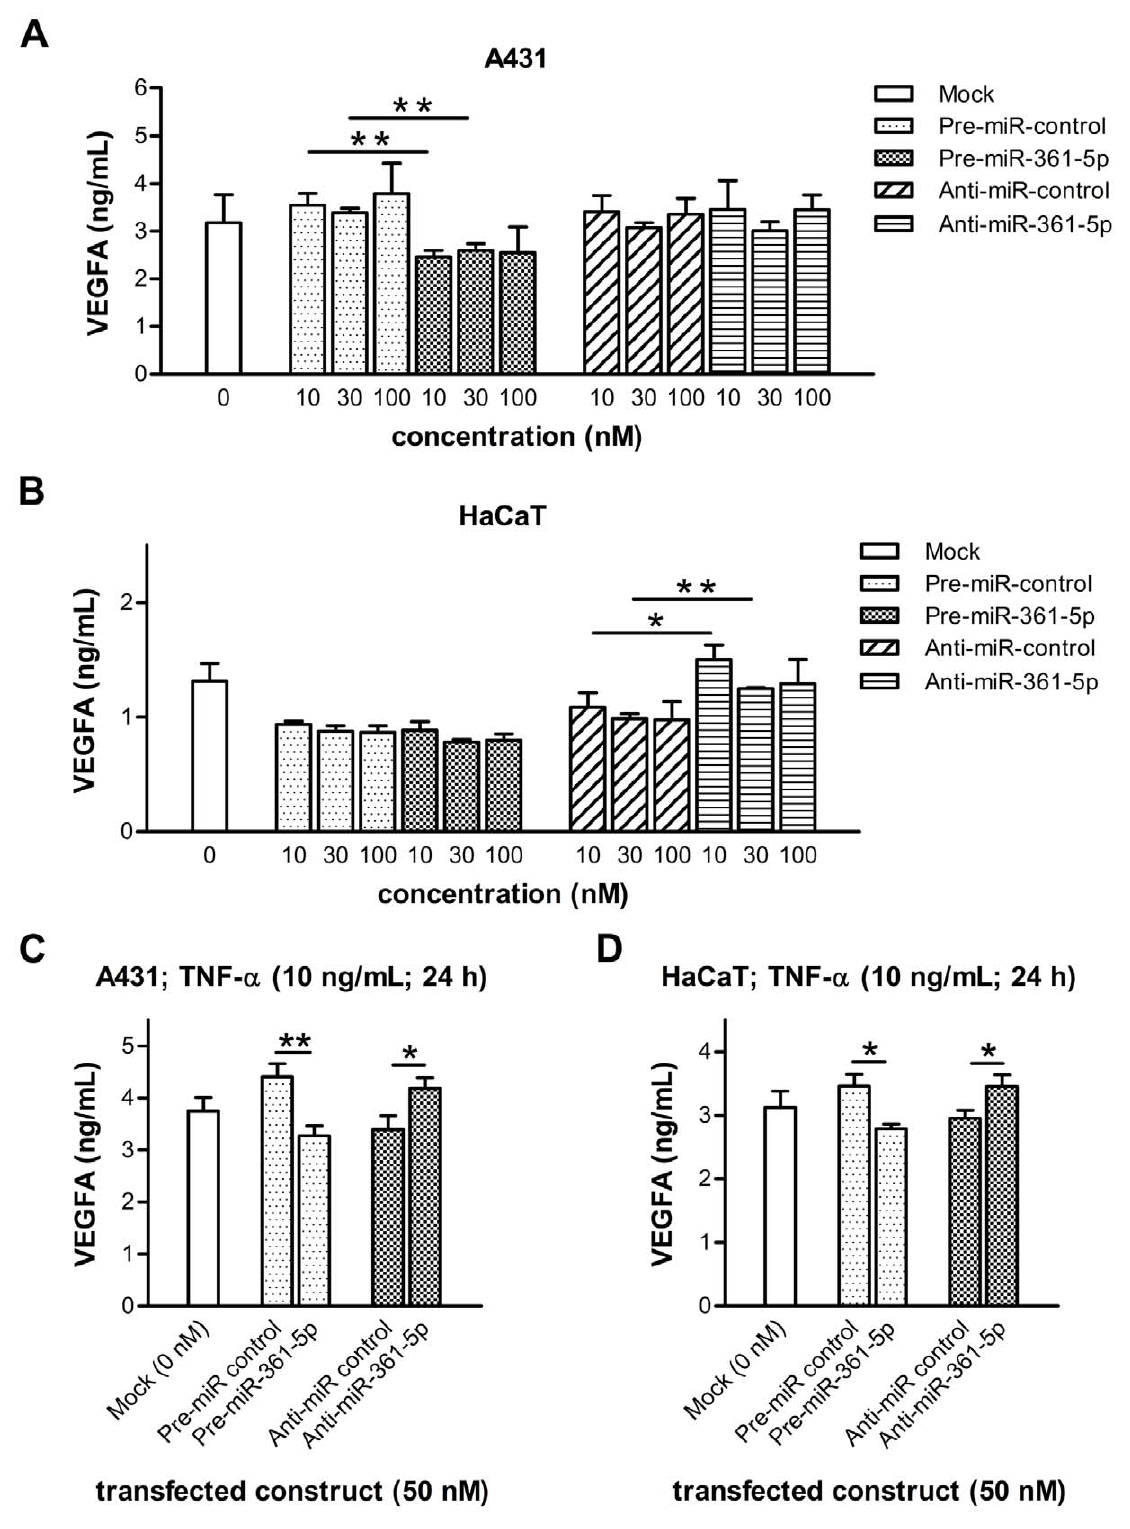
Figure 2. Impact of altered miRNA-361-5p levels on secretion of endogenous VEGFA. A431 and HaCaT cells were transfected with the indicated concentrations of miR-361-5p mimics, antisense inhibitors, or controls, either in the presence (A, B) or absence (C, D) of TNF- a . Cellular supernatants were analyzed for VEGFA protein content using a human VEGFA ELISA. Three independent experiments were performed in triplicate. Mean values 6 S.D. from a representative experiment are plotted. Two-tailed, unpaired t -tests were used to calculate P values (one and two asterisks denote P values , 0.05 and , 0.01, respectively).